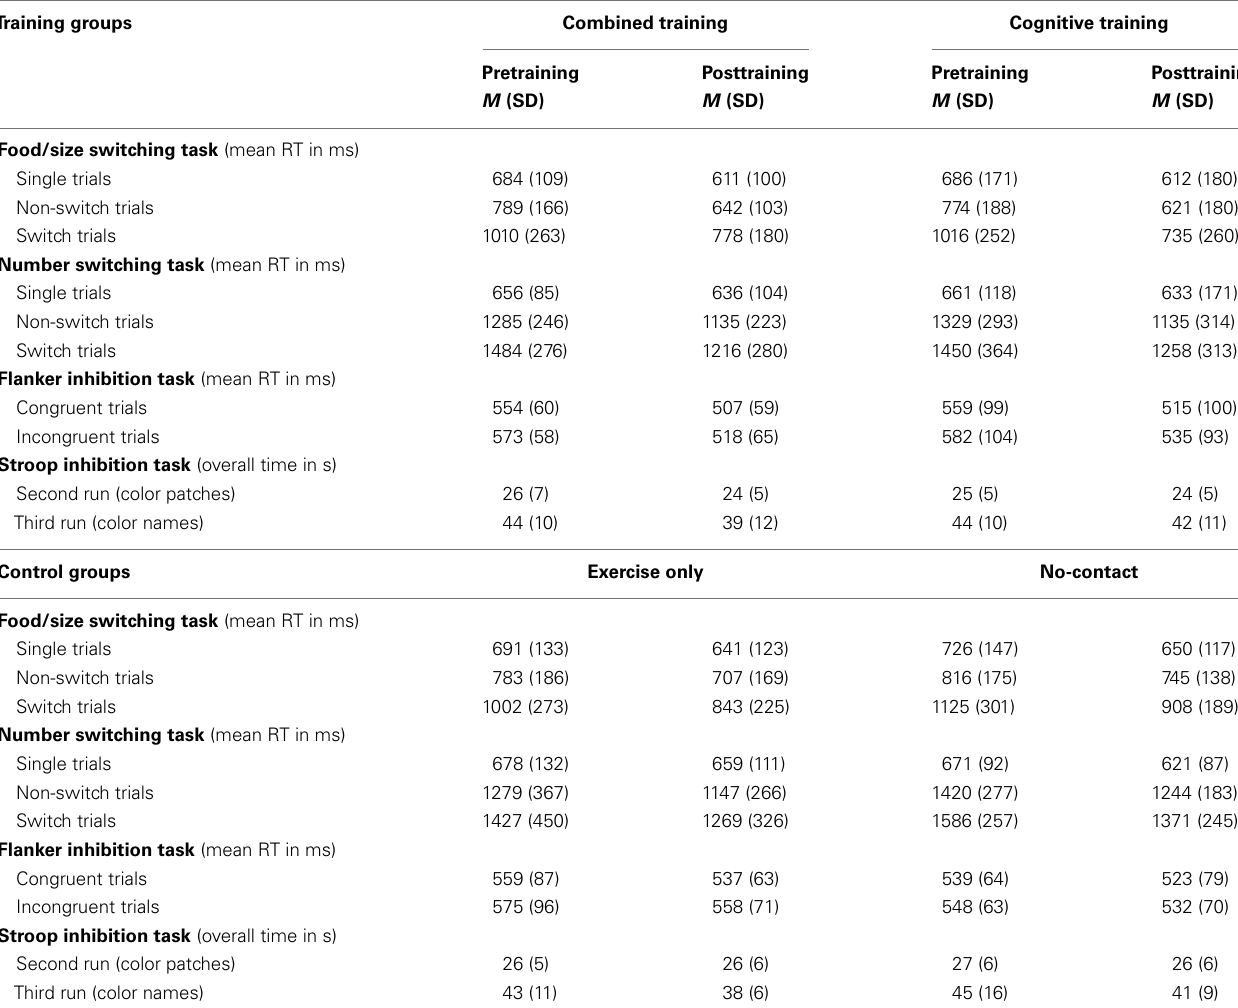
TableA1 | Mean RT data for transfer task switching and inhibition tasks in the training groups (combined and cognitive training only) and control groups (exercise only and